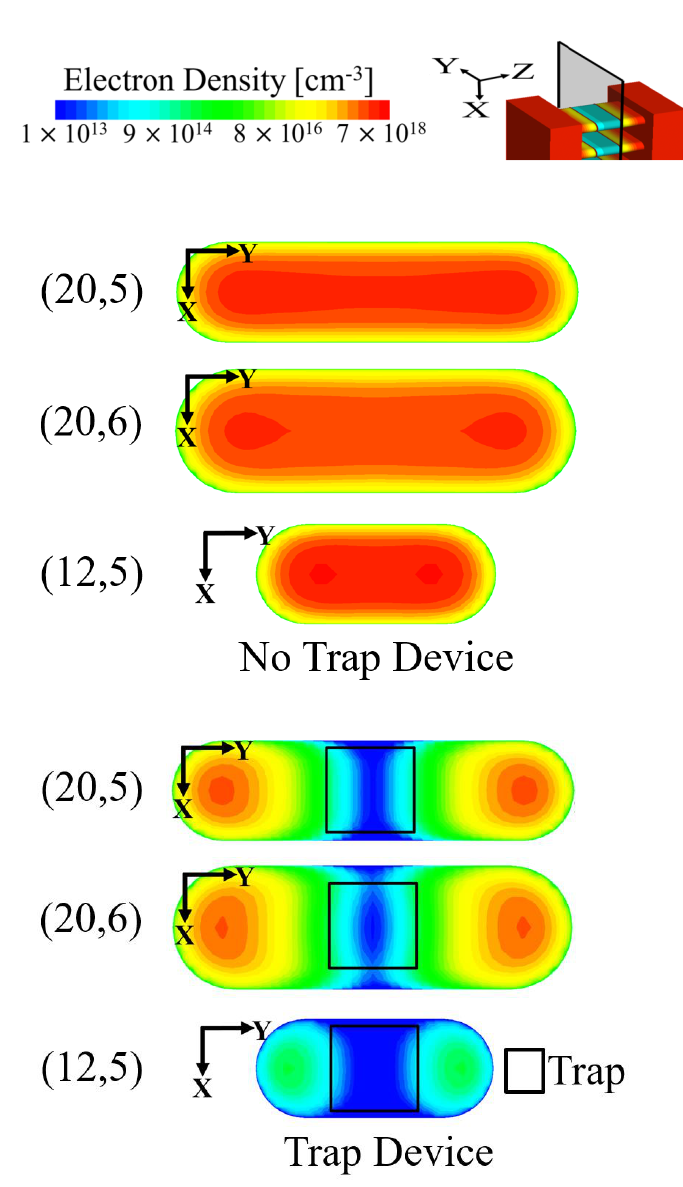
Figure 3. Electron density profiles of NS1 without and with displacement defect (source side, center of channel diameter in NS1 layer) along XY- plane at Z = −0.2 nm. (20,5), (20,6), and (12,5) denote the of channel diameter in NS1 layer) along XY-plane at Z = − 0.2 nm. (20,5), (20,6), and (12,5) denote the control, thick channel, and narrow channel devices, respectively. control, thick channel, and narrow channel devices,